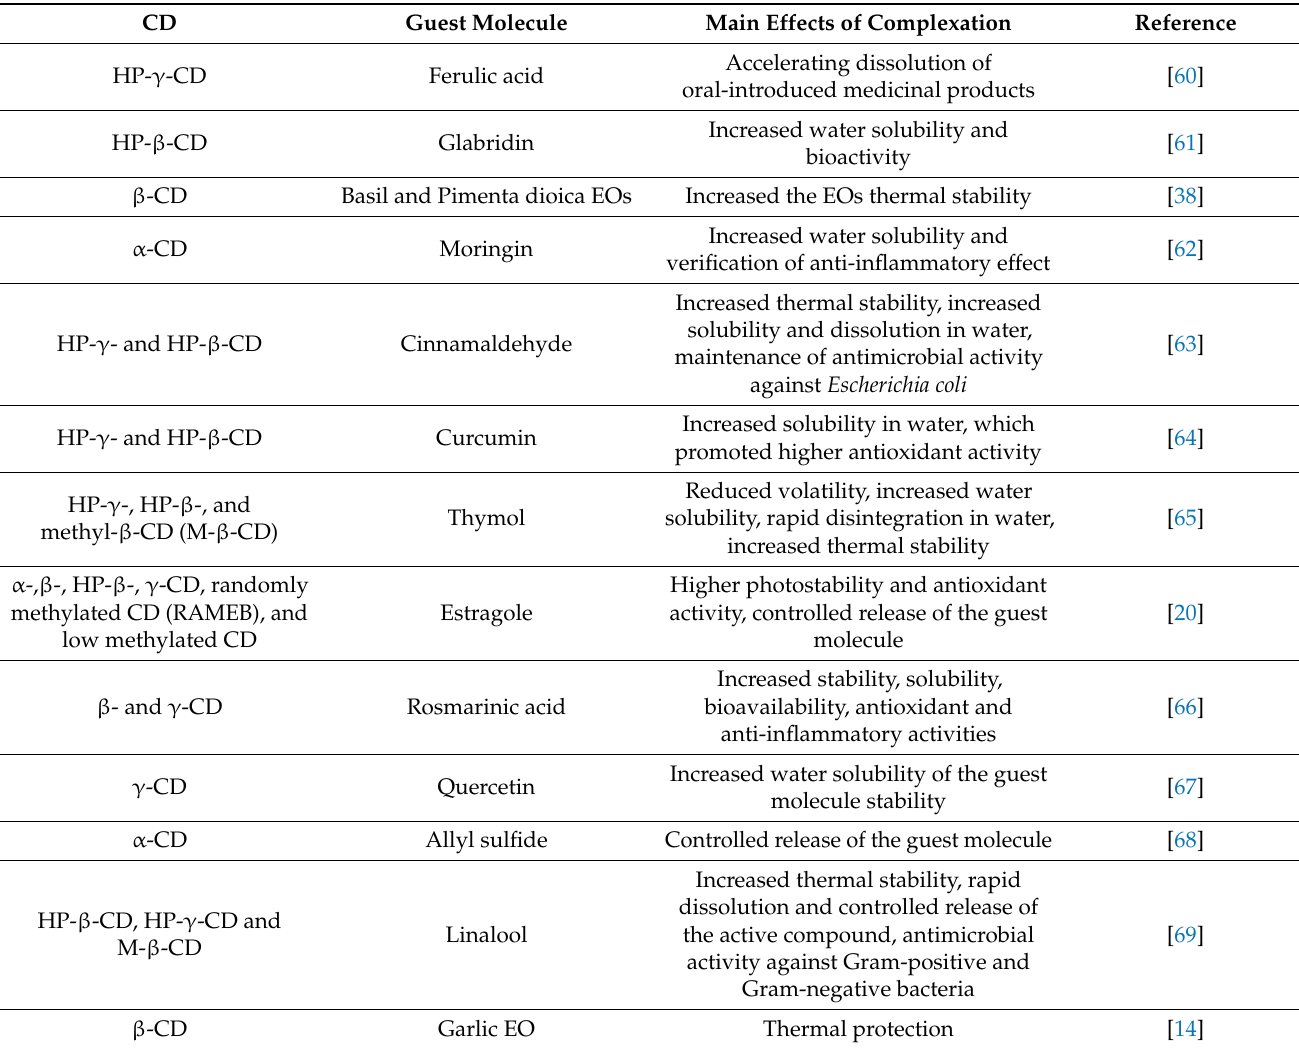
Table 2. Inclusion complexes obtained with several types of guest molecules and cyclodextrins